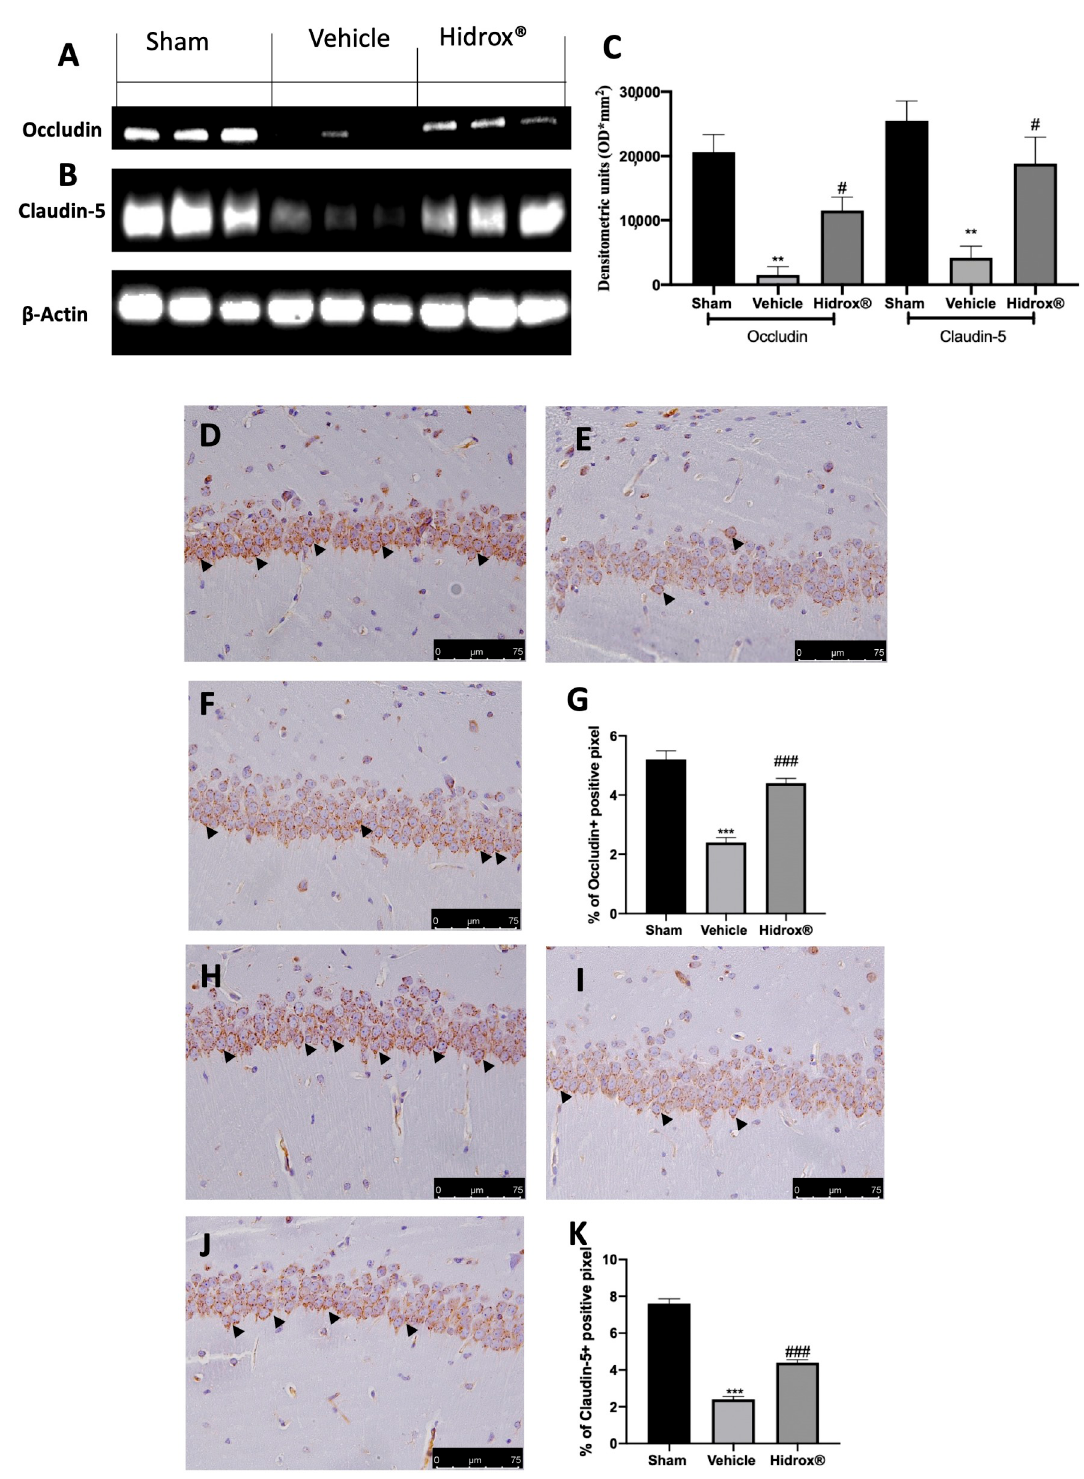
Figure 7. Hidrox ® administration partially restored tight junctions: Western blot analysis of occludin from hippocampal tissue ( A ), claudin-5 from hippocampal tissue ( B ), densitometric analysis ( C ), immunohistochemical analysis of occludin: sham ( D ), vehicle ( E ), Hidrox ® ( F ), graphical quantification of occludin expression ( G ); immunohistochemical analysis of claudin-5: sham ( H ), vehicle ( I ), Hidrox ® ( J ), graphical quantification of occludin expression ( K ). For the analyses, n = 5 animals from each group were employed. A p -value of less than 0.05 was considered significant. # p < 0.05 vs. vehicle, ** p < 0.01 vs. sham, *** p < 0.001 vs. sham, ### p < 0.001 vs.